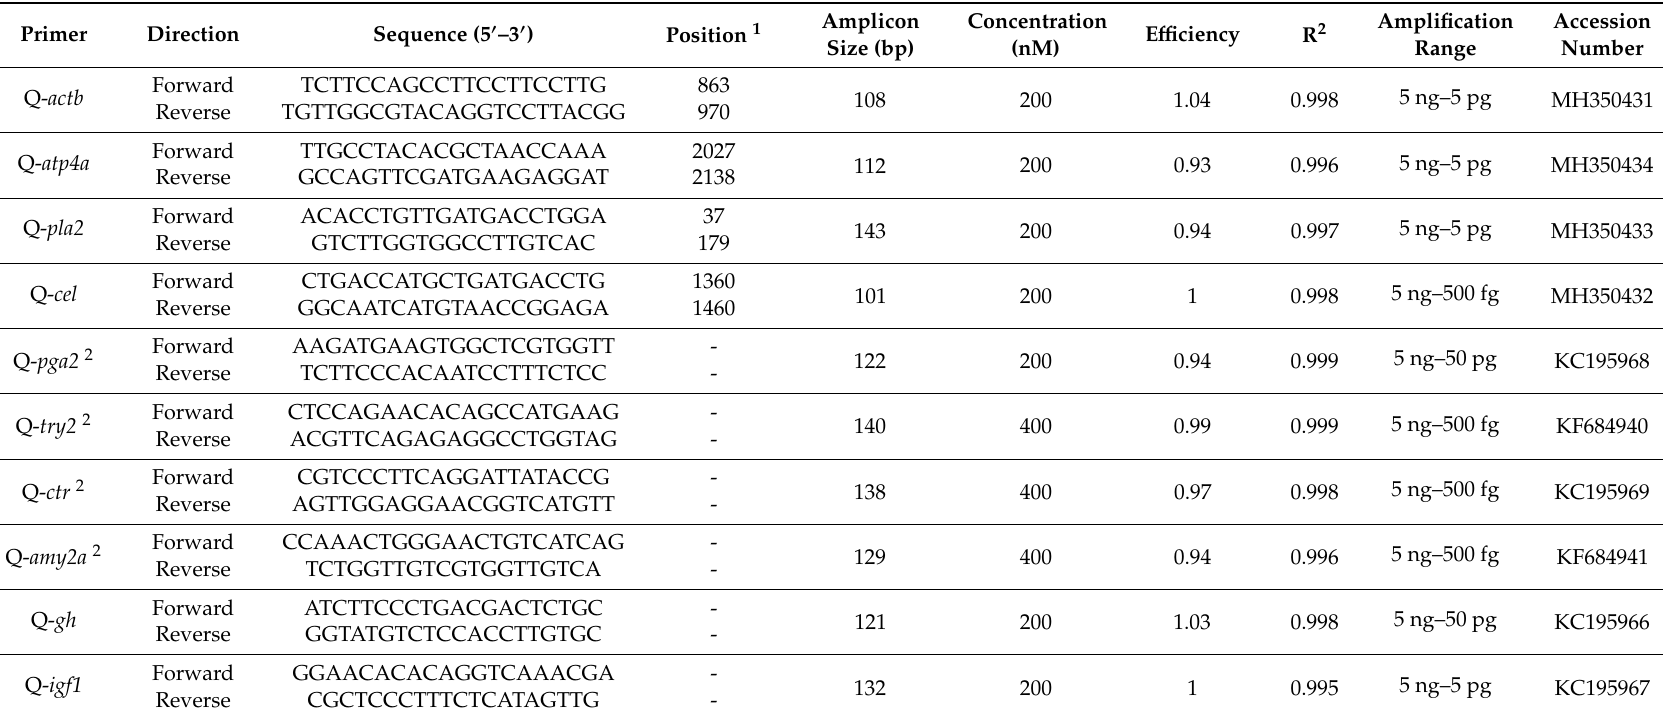
Table 1. Oligonucleotides used for quantitative real-time